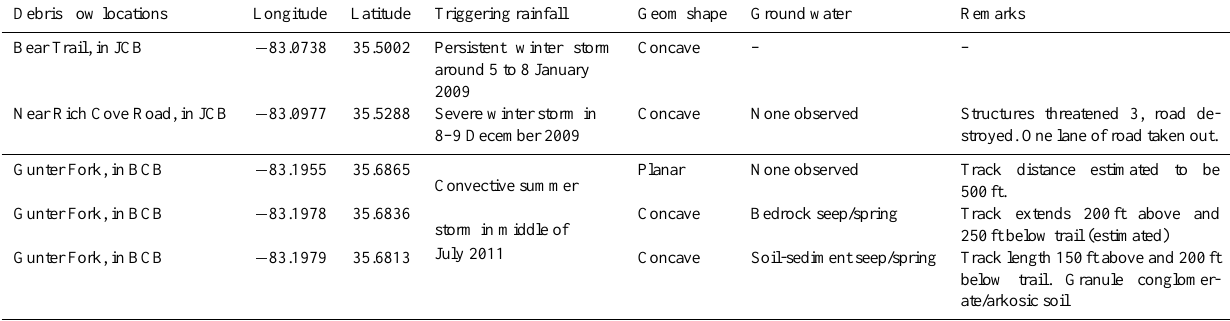
Table 2. Summary of debris flow sites’ characteristics. The NCDOT Materials Testing Laboratory in Asheville, North Carolina, conducted soil quality tests on the soil samples from the debris flow initiation zones (data provided by NCGS, from Dr. Richard